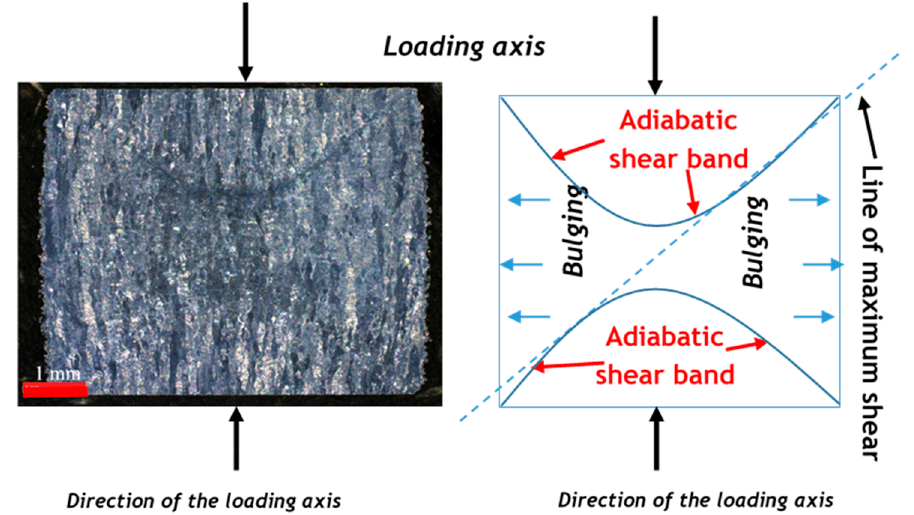
Figure 11. Typical optical micrograph and schematic description of the failure surfaces of a loaded specimen.